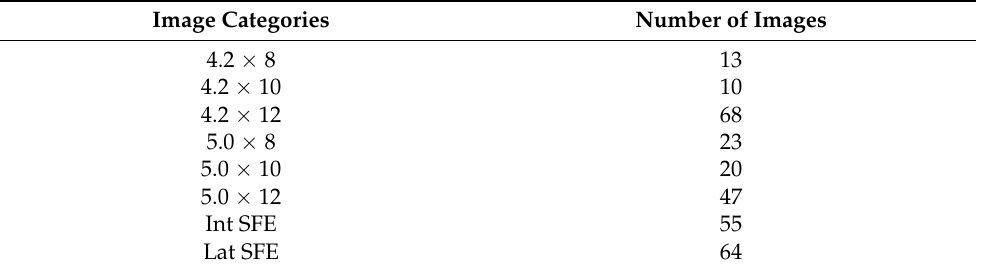
Table 1. The distribution of each image’s categories.